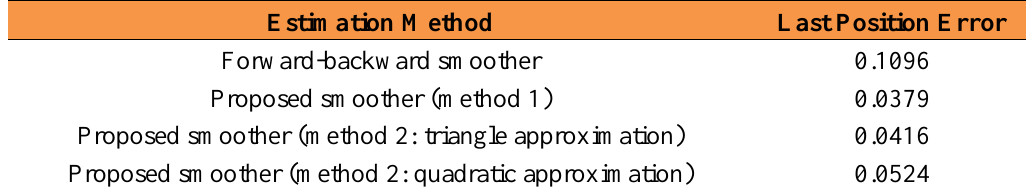
Table 2. The error of 0.95 m straight movement experiment.